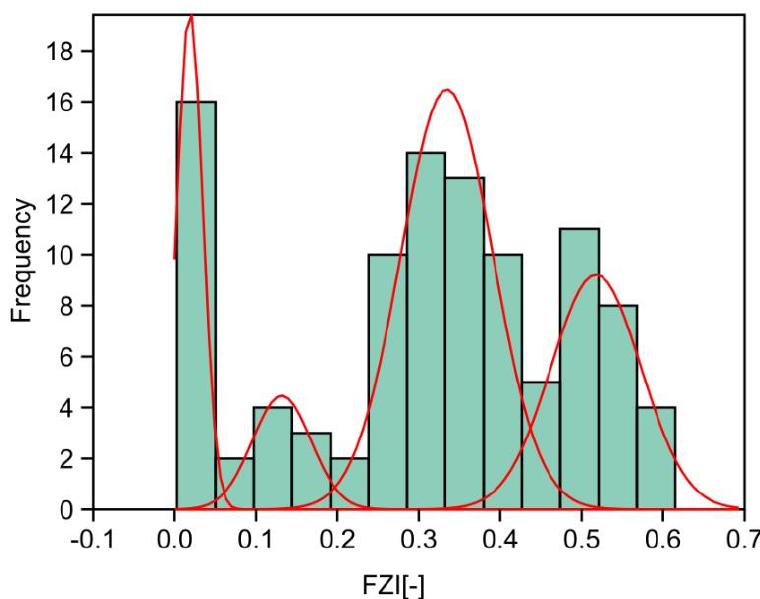
Figure 11. Clustering of Petrophysical Rock Types based on the histogram of Flow Zone Indicator (FZI). Based on the four modes of the histogram (red curve), four distinct Petrophysical Rock Types (PRT) can be classified.